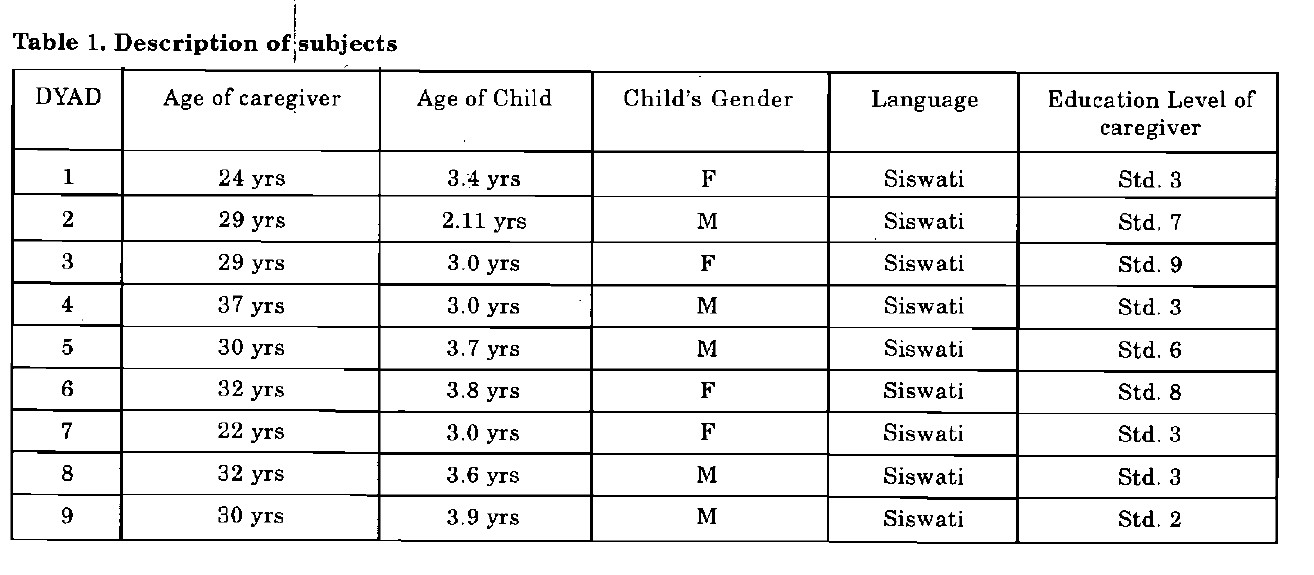
Table 1. Description ofjsubjects